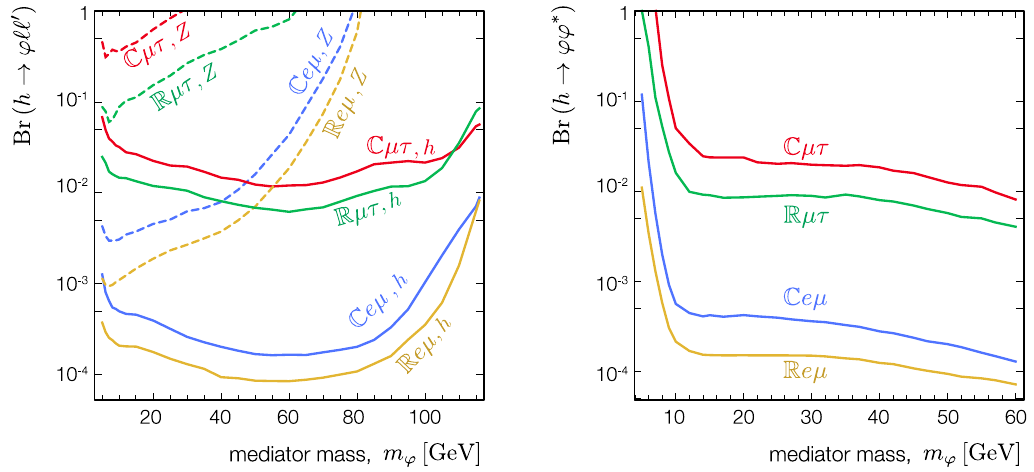
Figure 4 . Limits on the branching ratio at 95% cl for the processes listed in table 2. Left: the limits on the branching ratio from the Higgs-mediated channels ( solid ) in the case with (cid:20) = 0. The limits on Z -mediated channels are translated into the equivalent limits on Br( h ! ’‘‘ 0 ) using their analytical expressions in (4.8) ( dashed ). Right: the limits for the case with a non-zero quartic coupling (cid:20) 6 =